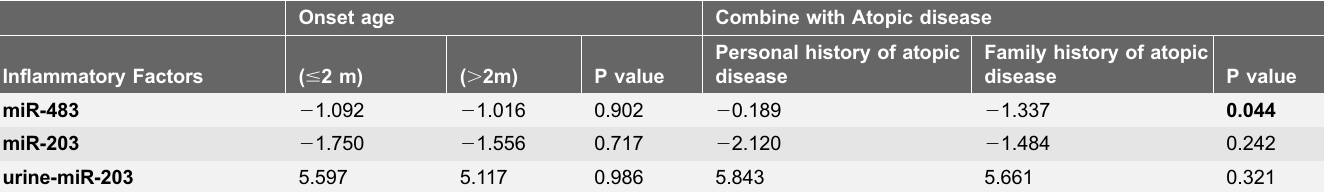
Table 3. Correlation analysis between childhood AD with atopic disease and childhood AD alone (T-test).